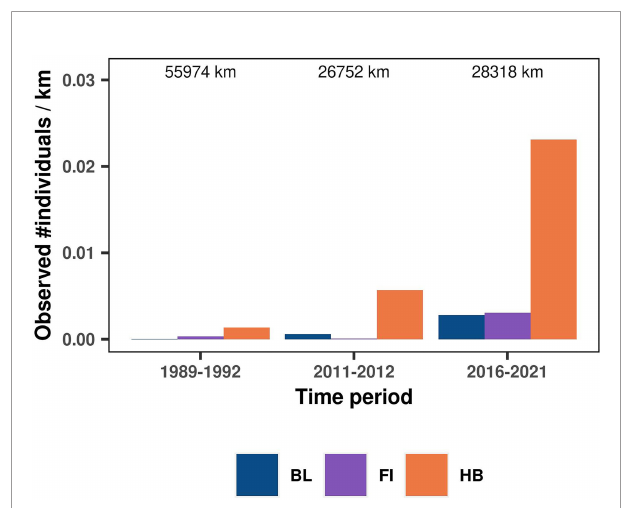
FIGURE 2 | Comparison of the number of individual whales observed per km of effort across systematic research surveys conducted in 1989-1992 (DELPHIN and ORWA marine mammal and seabird surveys), 2011-2012 (PaCSEA surveys) and 2016-2021 (present study). The numbers on top of each bar indicate kilometers surveyed in each period. See Supplementary Tables S2 – S3 for more details about systematic research survey data included in the comparison and Supplementary Figure S8 for alternative approach to the sighting rate